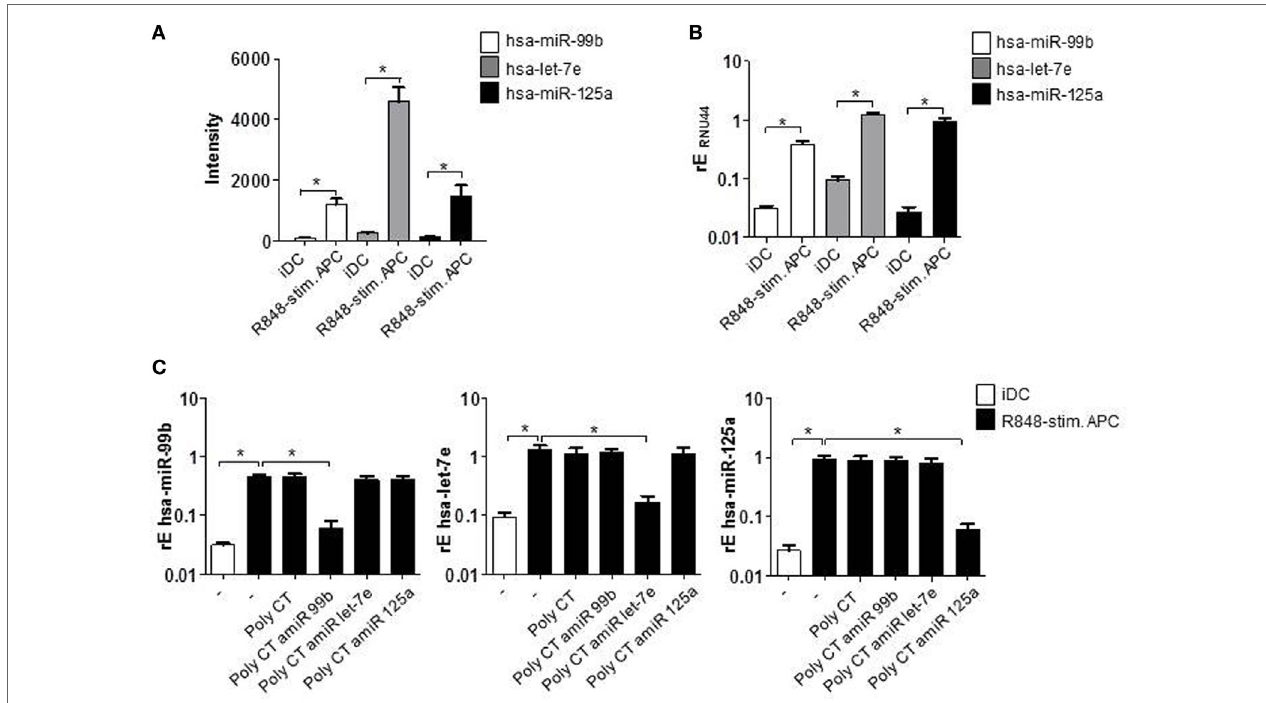
FigUre 1 | CD14 + monocytes were isolated from blood of healthy donors and stimulated with GM-CSF and IL-4 or GM-CSF, IL-4, and R848 to generate immature DCs (iDCs) and R848-stimulated suppressive APCs (R848-stim.APC), respectively. (a) miRNA abundance. iDCs and R848-stim.APCs were analyzed by miRNA array. Shown is the intensity (abundance of probe-target hybridization) of hsa-miR-99b, hsa-let-7e, and hsa-miR-125a. (B) RNA was isolated and cDNA produced. Induction of miRNAs was analyzed by quantitative (q) RT PCR using sequence-specific primer (RNU44 was detected as endogenous control for normalization) and SYBR Green Master mix. (c) Monocytes were treated with antagomiRs (amiRs) against miR-99b, let-7e, or miR-125a or just the poly CT sequence as control. The next day, cells were stimulated to differentiate to iDCs or R848-stim.APCs. After 24 h, cells were harvested, RNA was purified, cDNA was produced, and qRT PCR was performed. (a–c) Mean values and SD of three individual